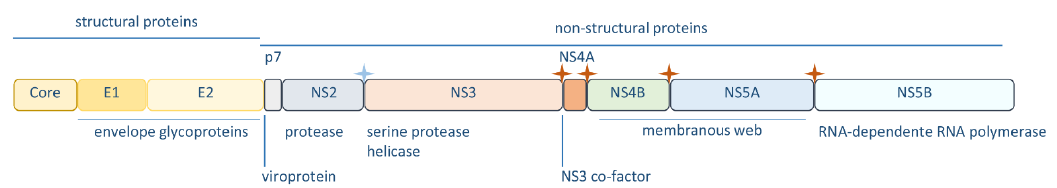
Figure 1. Schematic representation of the hepatitis C virus (HCV) polyprotein referring to the individual proteins and their relevance for the HCV life cycle. The stars indicate cleavage sites of auto-proteases—blue star: NS2-3; red star: NS3-4A. N-terminal processing is accomplished by host proteases.